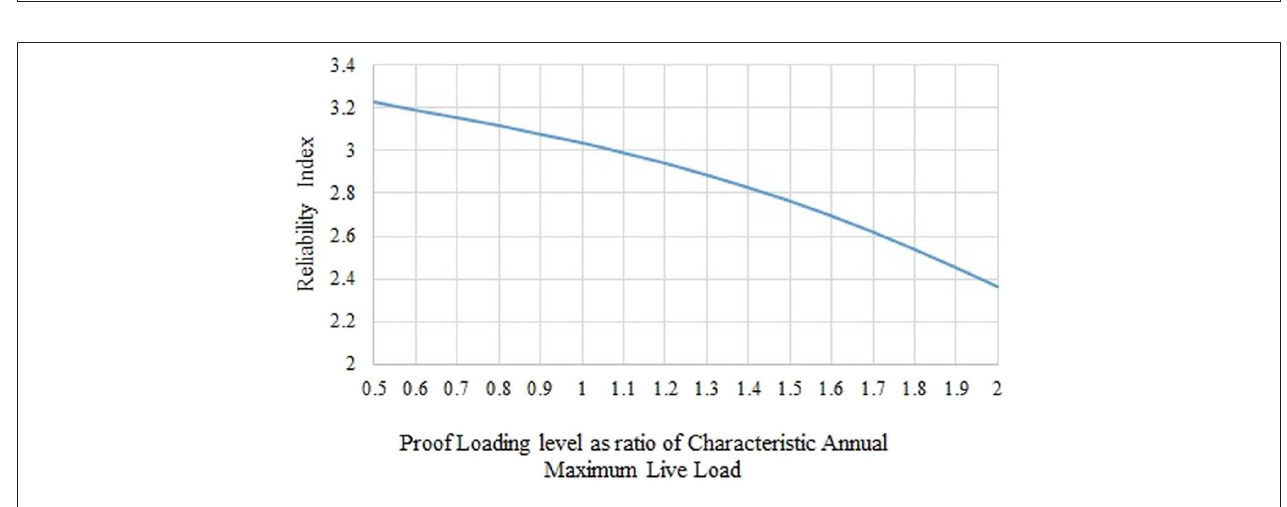
service life of the bridge is obtained with the summation of the annual risks. The annual risk of structural failure is computed as the product of the annual probability of failure and the cost incurred as a consequence of failure. In the year of the testing,